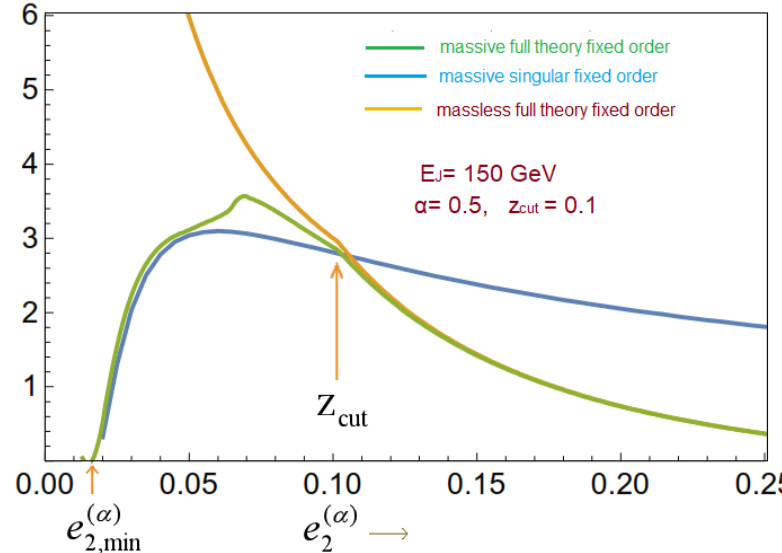
Figure 7 . Fixed-order cross section at one loop for the e ( (cid:11) )